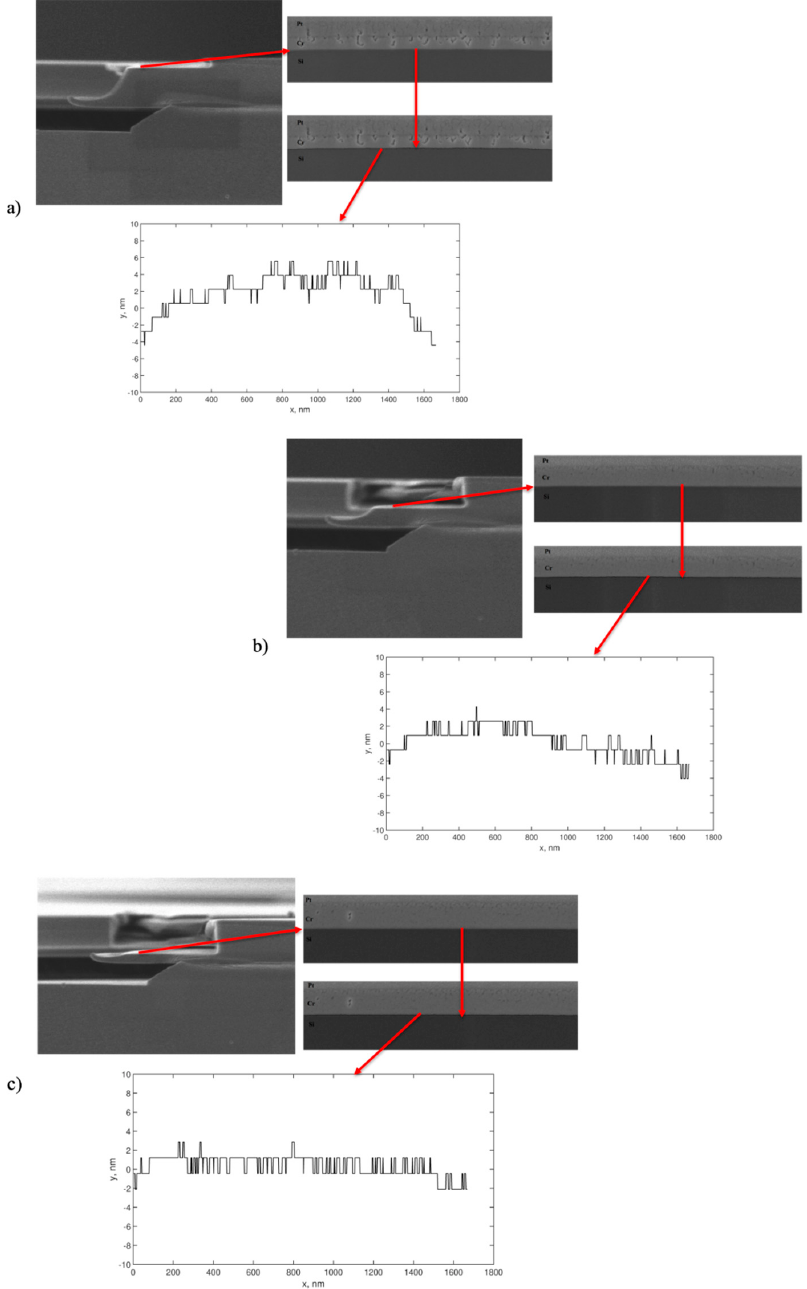
Figure 4. SEM images of profiles obtained using an ion beam, images of the Si-metal interface and the profile of the silicon element boundary (plotted along both axes; unit: nm) in different regions: ( a ) closer to the upper edge of the profile; ( b ) at the point of the profile bend; ( c ) near the wedge.